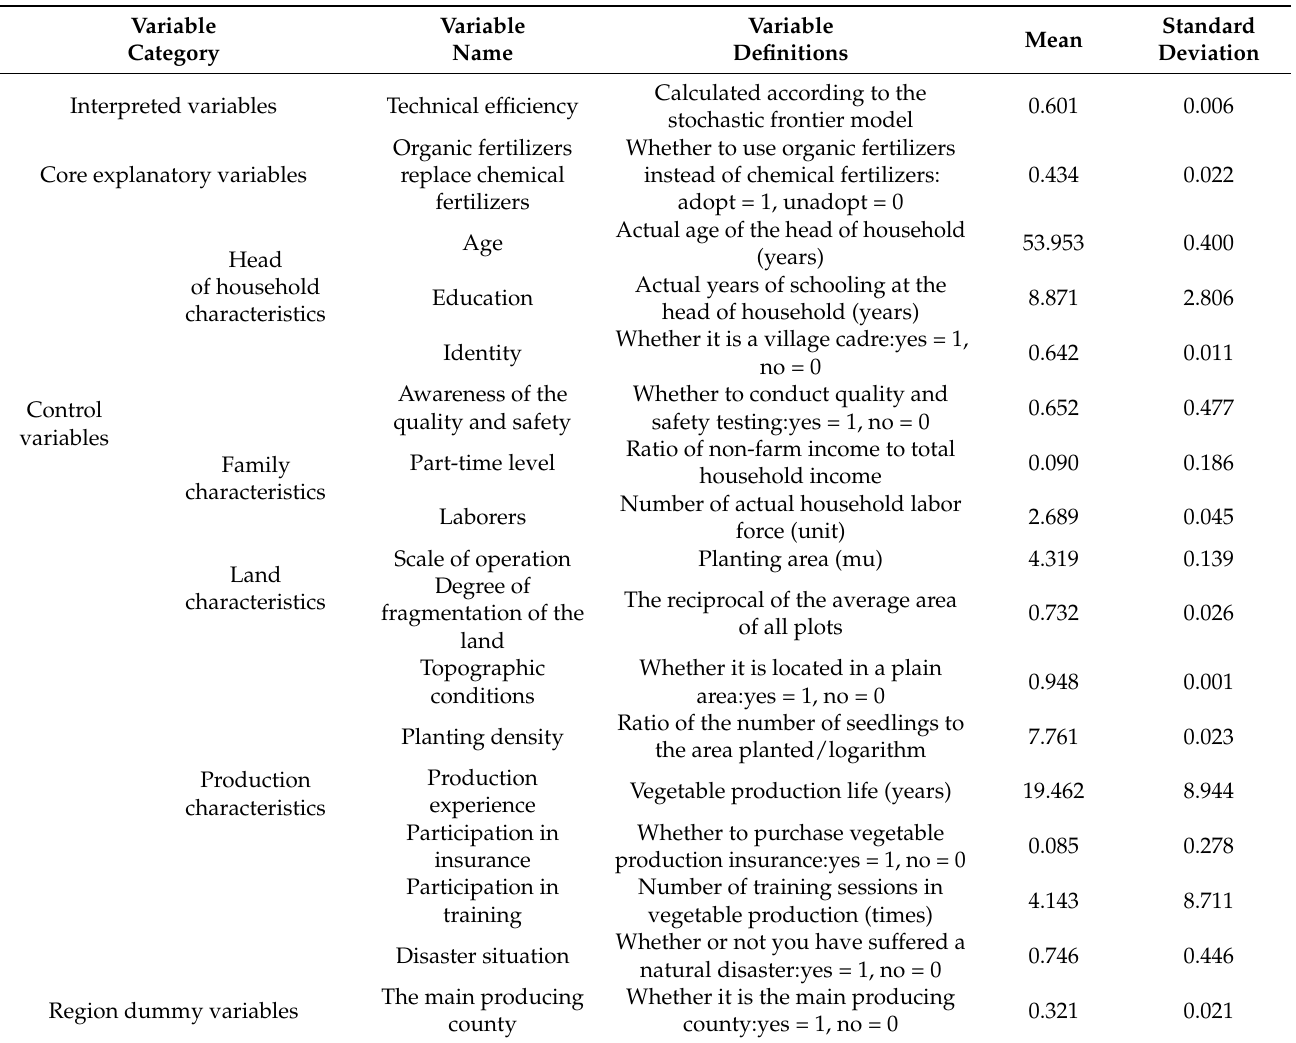
Table 2. Variable definitions, assignments, and descriptive